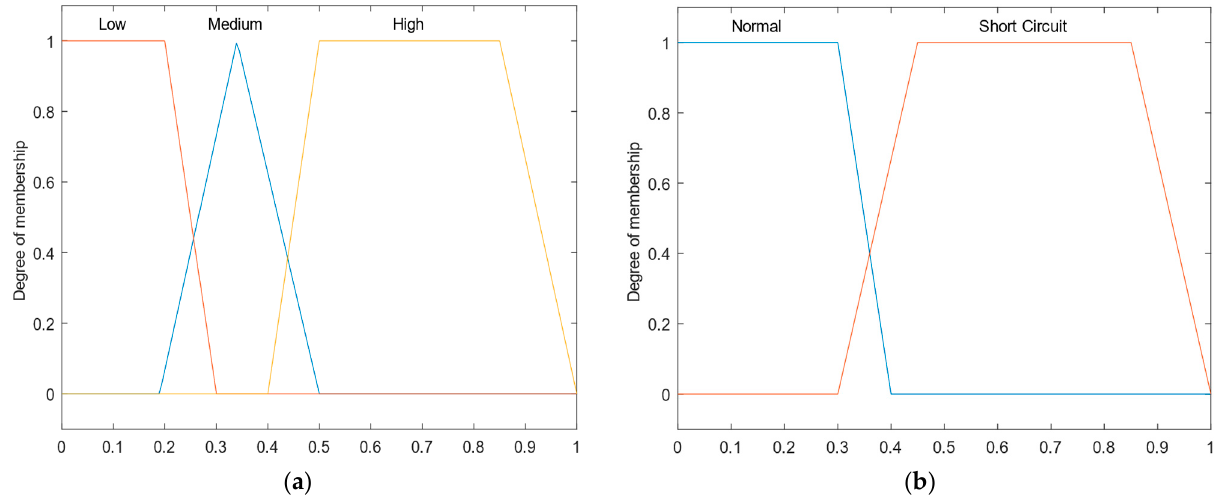
Figure 6. Linguistic variables and membership functions. Linguistic variables: ( a ) Input variables; and ( b ) Output variables.